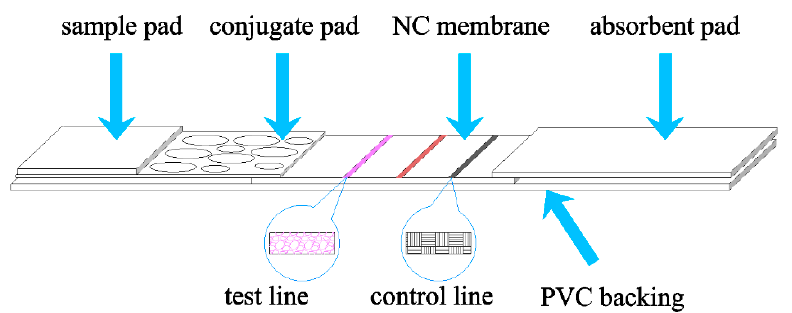
Figure 1. Structure of a lateral flow strip. It has at least one test line and a control line which serves as the reaction area.